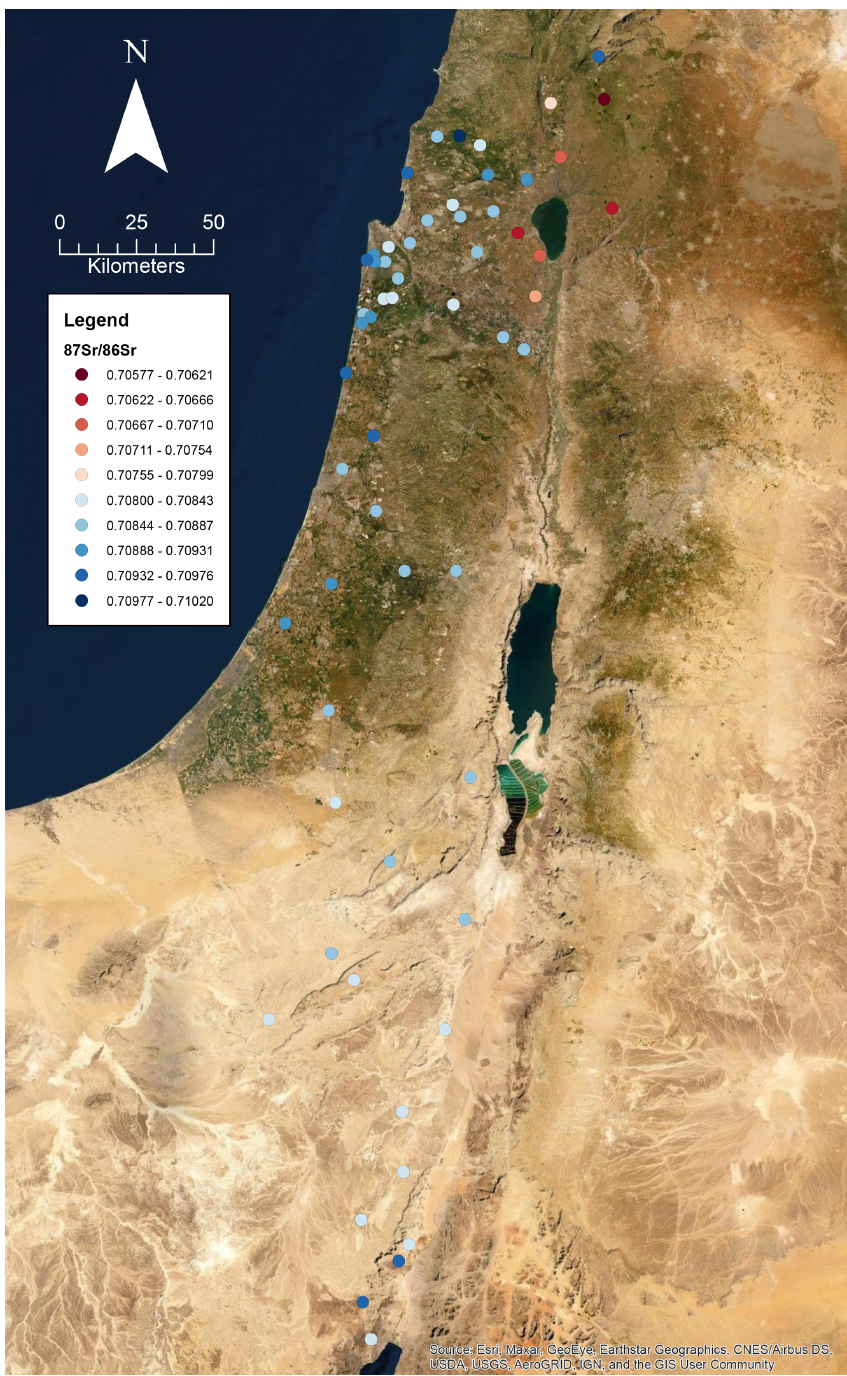
Figure 3. Bioavailable 87 Sr / 86 Sr of soil samples.